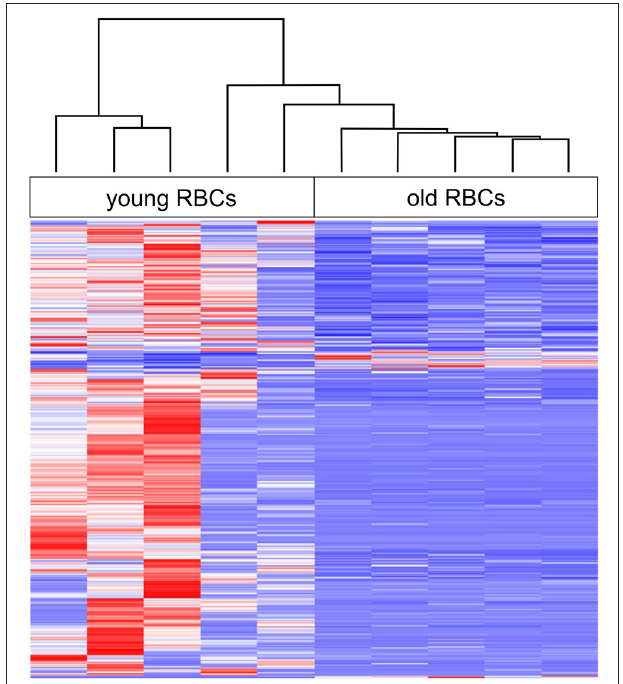
FIGURE 1 | Heat map of age-related changes in gene expression of erythrocytes (RBCs) with hierarchical clustering (complete linkage method with Euclidean distance measure) of all biological replicates. Red indicates highest expression and blue indicates lowest expression.